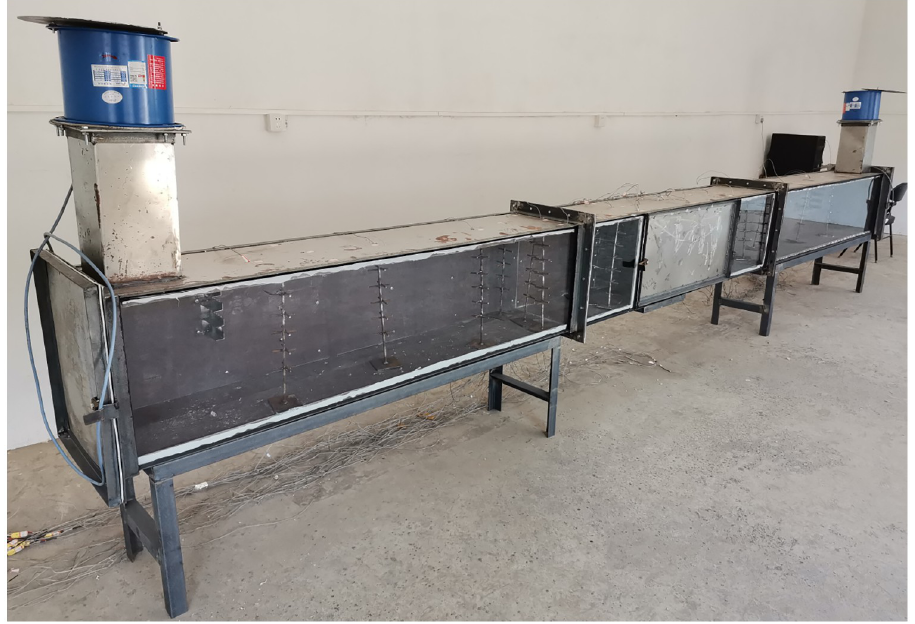
Fig 1. Physical model of cable compartment in utility